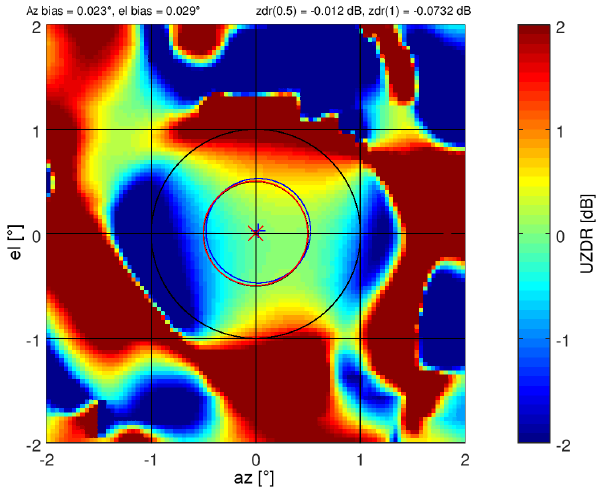
Figure 6. Hohenpeißenberg Z DR antenna pattern (UZDR) taken on 18 May 2011, to be compared with the pattern of differential solar power (Fig. 3a). See also Fig. 2.